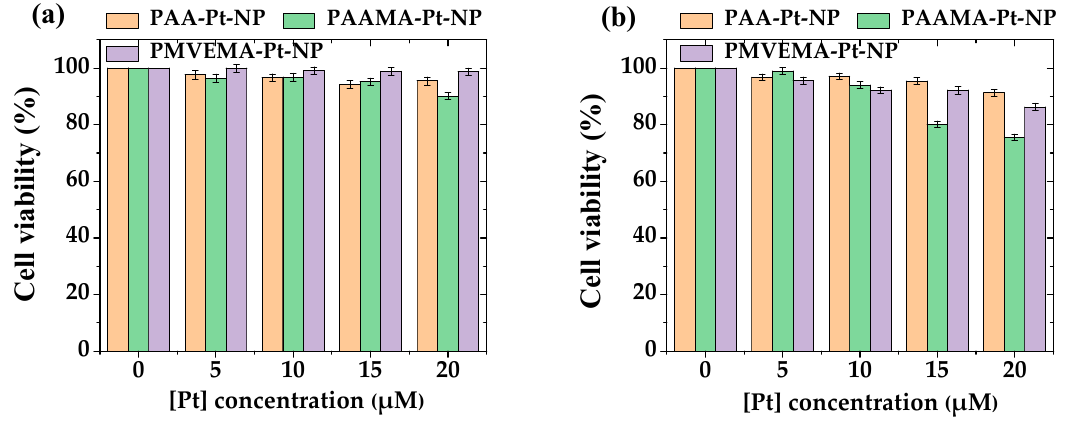
Figure 7. In vitro cellular cytotoxicity of PAA-, PAAMA-, and PMVEMA-coated Pt-NPs in ( a ) HepG2 and ( b ) HEK293 cells as a function of [Pt] concentration, showing low toxicity up to 20 µM [Pt].